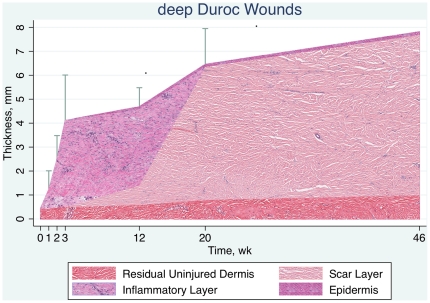
Schematic of time course of wound thickness in deep Duroc wounds.A thick granulation tissue layer is present from wounding to approximately 12 weeks and the scar layer progressively thickens to 46 weeks.